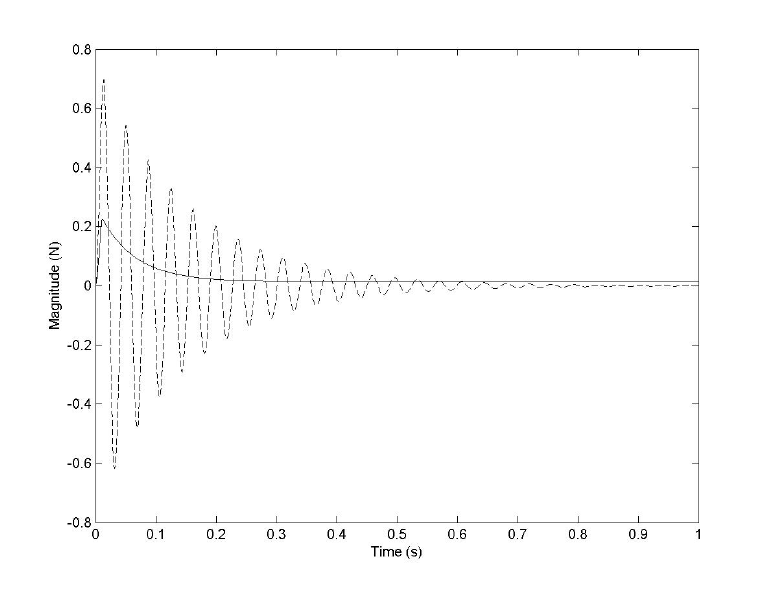
Fig. 16. Transmitted force variations of the system using the PD controller subjected to impulse engine disturbance. Open loop (–) and PD controlled (solid).